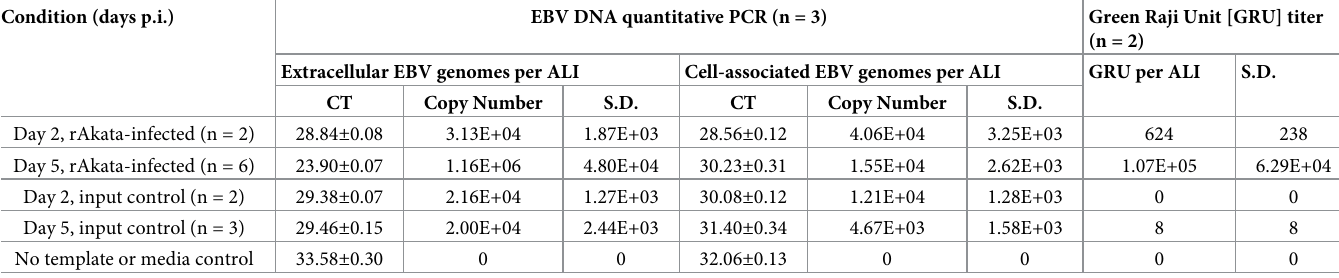
Table 2. Summary of EBV quantitative PCR and infectious titer results for pseudo-ALI cultures from donor no.4. Condition (days